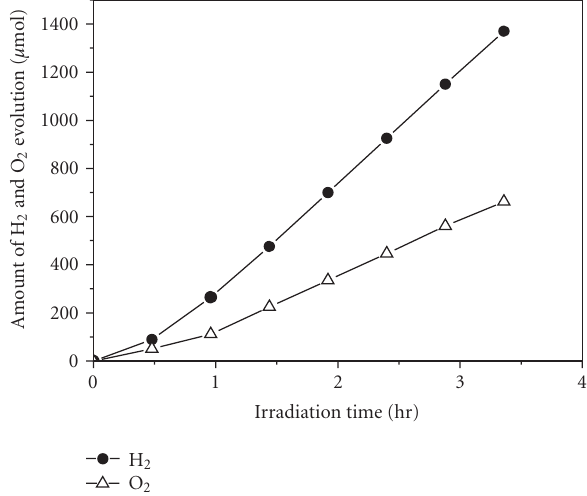
Figure 10: Cumulative amount of gas evolution with irradiation time in pure water over NiO(0.05 wt%)/NaTaO 3 . (NaTaO 3 powder synthesized by spray pyrolysis, mean residence time = 1.80 sec- onds, spray pyrolysis temperature = 1173 K, precursor preparation temperature = 333 K, precursor concentration = 0.125 M, carrier gas (air) flow rate = 5L/min, Na/Ta = 1.00. Reaction conditions: photocatalyst type, NiO(0.05 wt%)/NaTaO 3 , amount of distilled water, 500mL, photocatalyst concentration = 1.0gL − 1 ).